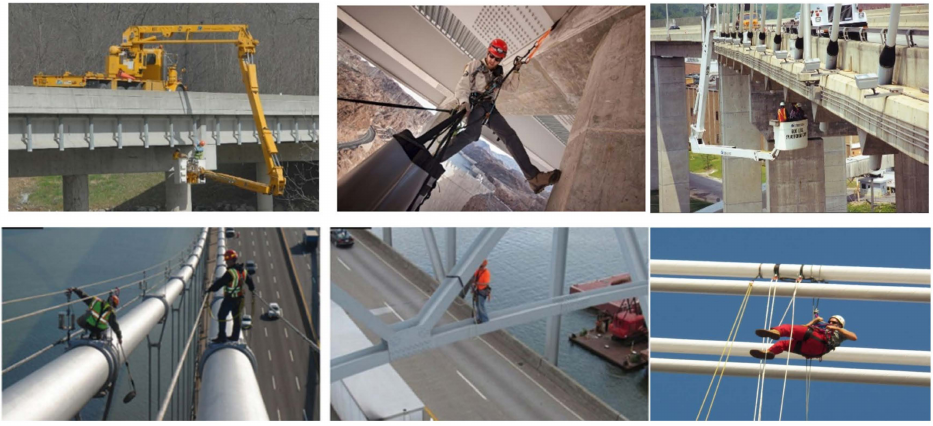
Figure 33. Dangerous bridge inspections [108–110].